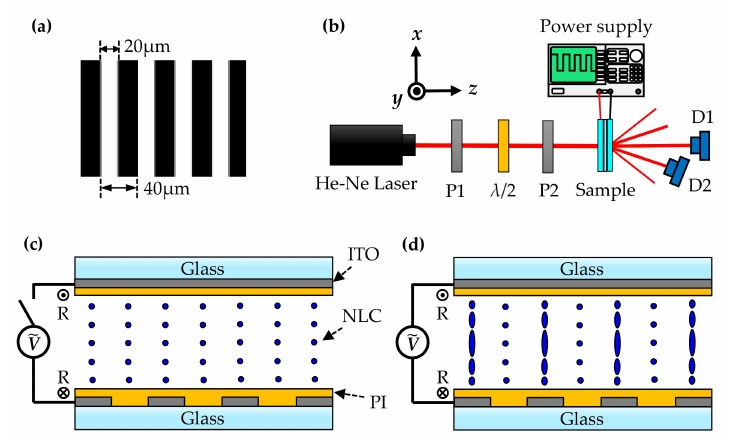
Figure 1. Schematics of ( a ) the electrodes, ( b ) the experimental setup, ( c ) sample without applied voltage, and ( d ) sample with applied